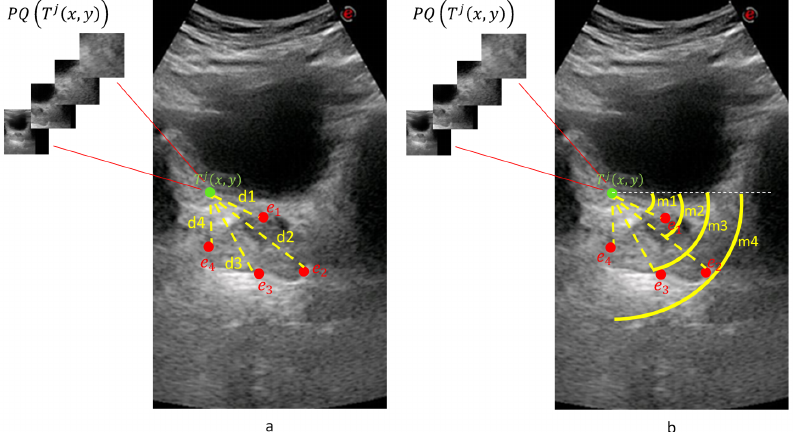
Figure 6. Measurement of the distance ( a ) and the orientation ( b ) class values for a given quadruplet patch PQ ( T j ( x , y )) . For a sample point T j ( x , y ) on a transverse image where four diameter end points ( e 1 , e 2 , e 3 , e 4 ) exist, classes for eight different tasks are